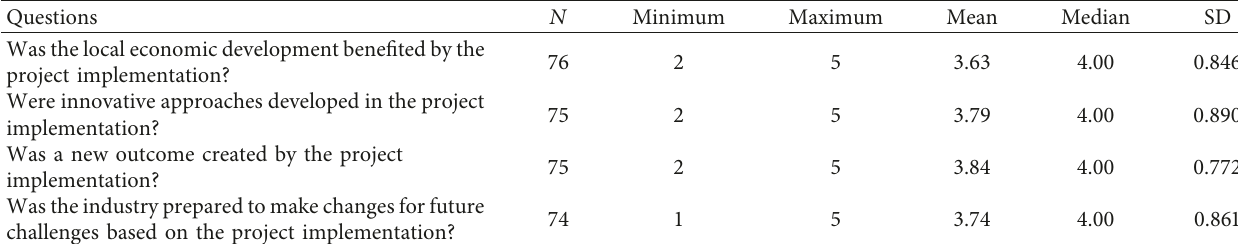
Table 7: Descriptive data of the project success dimension “preparing for the future.”